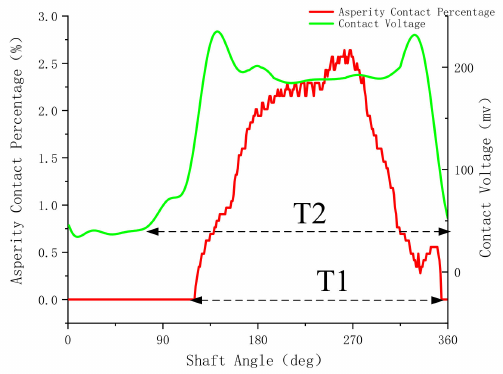
Figure 8. Contact percentage compared with the contact voltage (3000 r / min and 60 MPa).